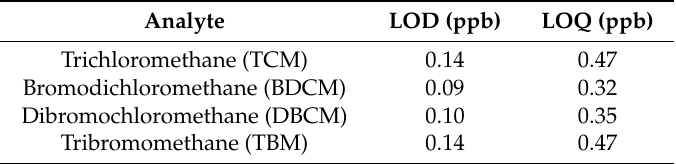
Table 2. Limits of detection (LOD) and limits of quantification (LOQ) for the target analytes. Analyte LOD (ppb) LOQ (ppb) Trichloromethane (TCM) 0.14 0.47